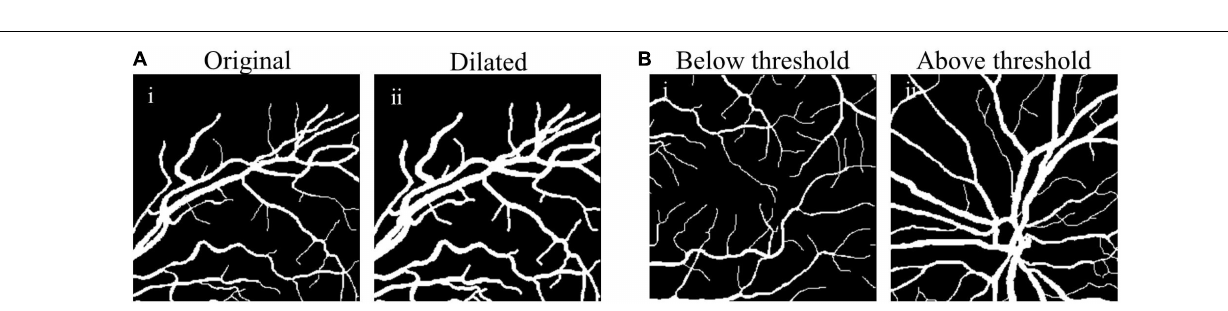
Frontiers in Neuroscience |